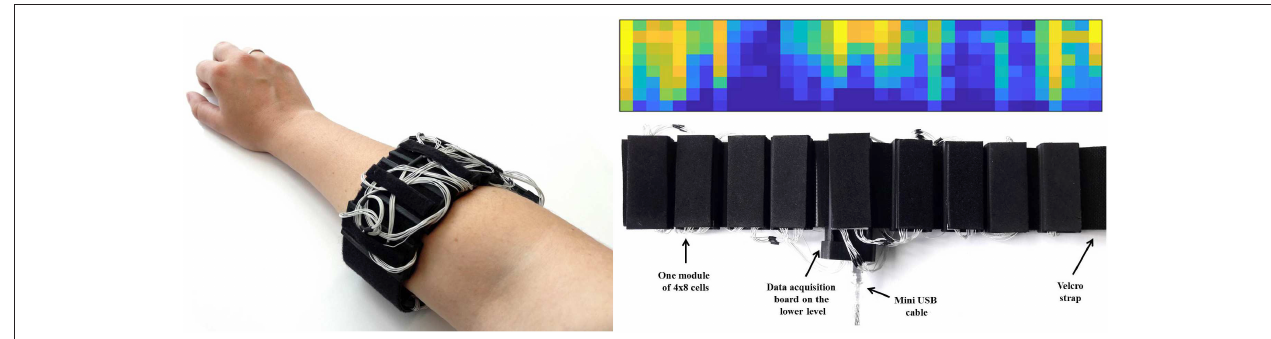
FIGURE 3 | Picture of the tactile bracelet, consisting of 9 boards of 32 cells each (8 vertical and 4 horizontal), and visual representation of the